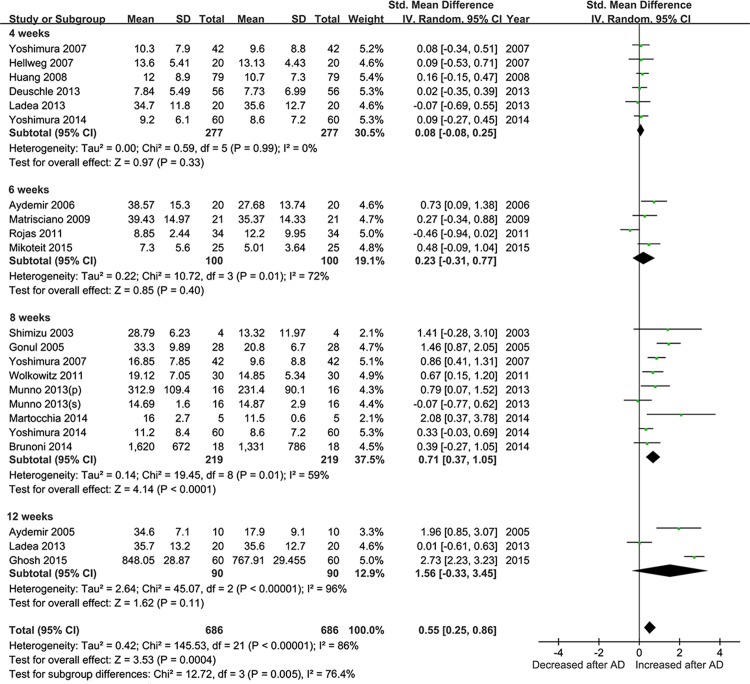
Meta-Analyses for the levels of BDNF pre- and post- antidepressant with differenti drugs treatment (less than 12 week).Forest plots showing summary effect sizes of differential antidepressants (venlafaxine, paroxetine, sertraline and escitalopram) on BDNF concentration changes